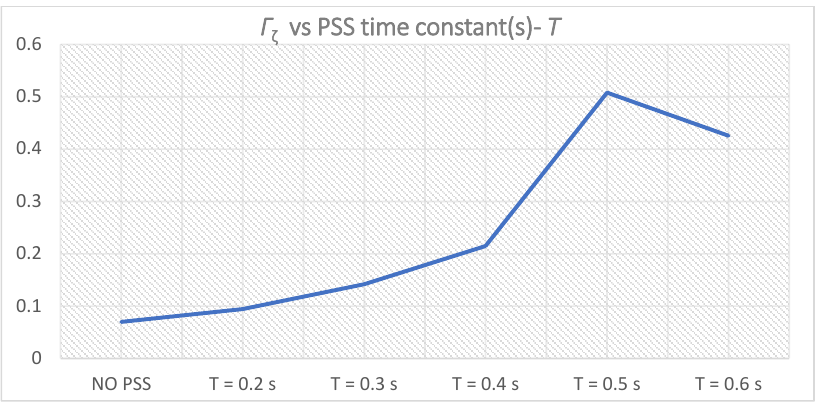
Figure 10. Γ ζi for PSS parameters K = 10, T = T i, 1 = 0.2 – 0.6 s. Figure 10. Γ ζ i for PSS parameters K = 10, T = T i, 1 = 0.2–0.6